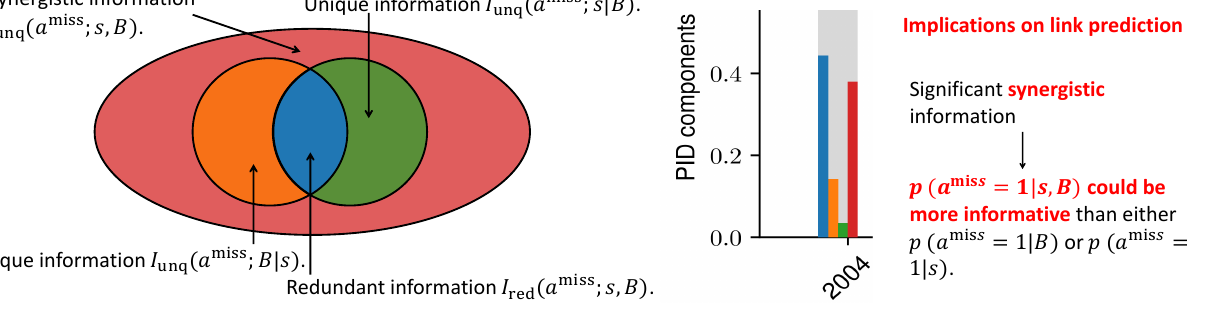
Figure 3. Overview of the link-prediction-motivated PID framework. Sub-figure ( A ) shows the motivation of this framework: A priori community structures in the technology-convergence network naturally provide a scaled-down replica of the original network, and we would like to explore how this multi-scale property contributes to link prediction. Sub-figure ( B ) shows that the micro-scale structure and its scaled-down replica are measured by local similarity measures and community-based indices, respectively. Sub-figure ( C ) demonstrates the PID of the joint mutual information I in which significant synergistic information could imply that the joint conditional probability, given two scales, could be more informative than either scale alone. Note that, in the right image of sub- figure ( C ), the colors blue, red, orange and green represent the relative redundant information ρ red , the relative synergistic information ρ syn , and two types of relative unique information, ρ unq ( B B ) , and ρ unq ( s |